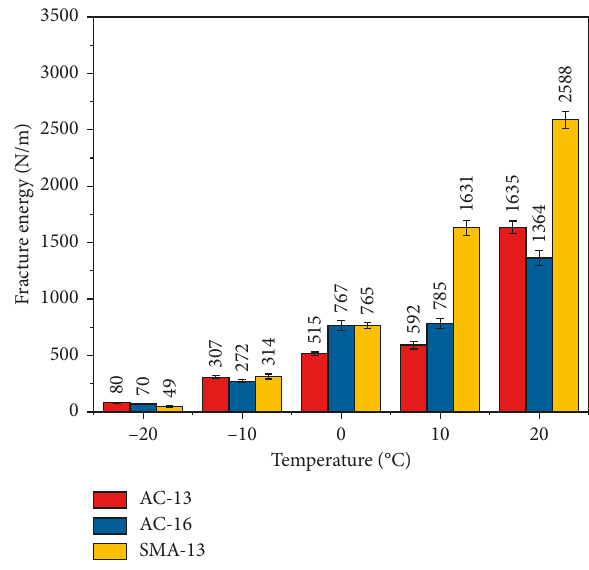
Figure 12: Fracture energy at different